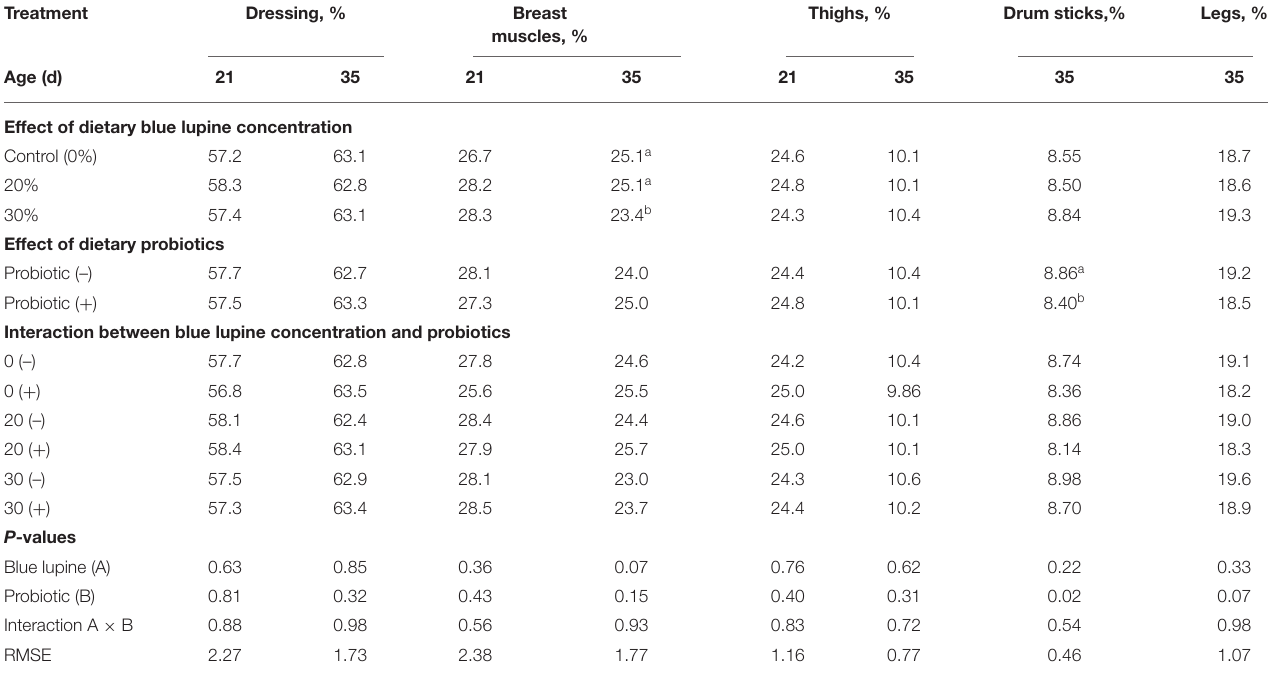
TABLE 5 | Effect of blue lupine and probiotics on carcass traits of broiler chickens at 21 and 35 d of age. Treatment Dressing, % Breast Thighs, % Drum sticks,% Legs, % muscles, % 21 35 21 35 35